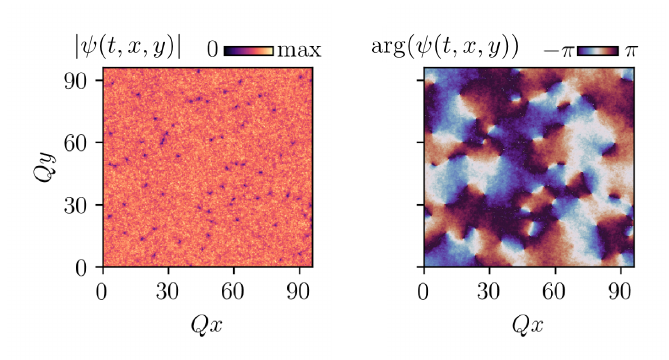
Figure 2: Amplitudes (left) and phases (right) of an example field configuration at time Qt =